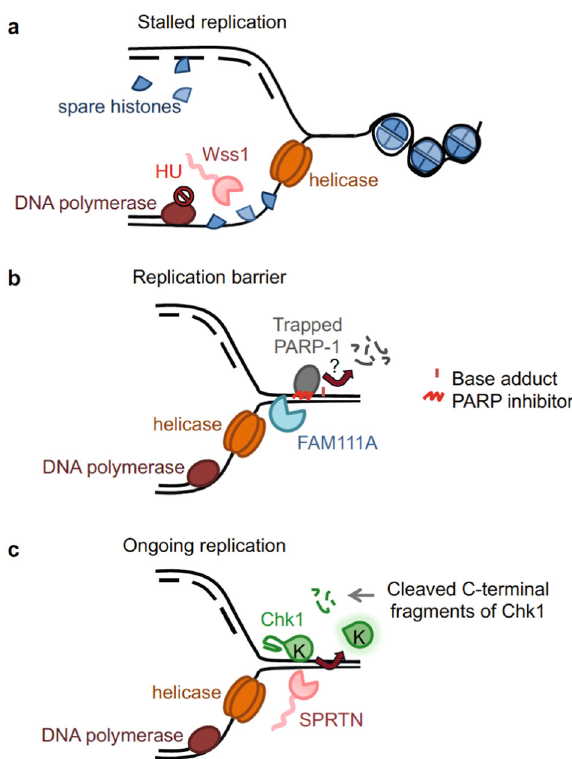
Fig. 4 Proteolysis of non-DPC substrates during DNA replication. a Wss1 cleaves excess histones binding to ssDNA after fork stalling. ssDNA is formed after HU. b PARP-1 is recruited to DNA to repair different types of damage, including base adducts generated by alkylating agents. In the presence of PARP inhibitors, self-PARylation and chromatin dissociation are blocked. Trapped PARP-1 represents a barrier for replication. FAM111A confers resistance to PARP inhibitors, but whether it acts proteolytically on PARP-1 awaits formal veri fi cation. c During DNA replication SPRTN cleaves the C-terminus of Chk1 and releases the active kinase domain (K) from